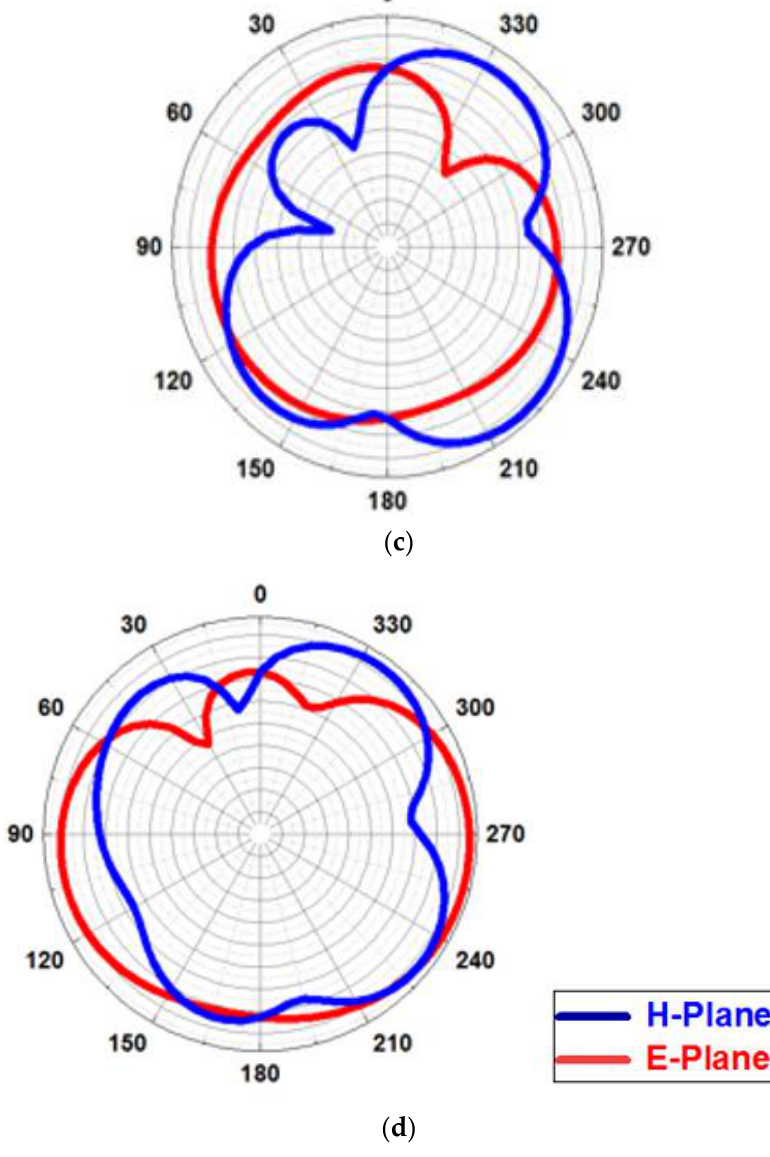
Figure 27. Radiation Patterns at ( a ) 5.8 GHz, ( b ) 8.7 GHz, ( c ) 10.95 GHz, ( d ) 13.25 GHz.